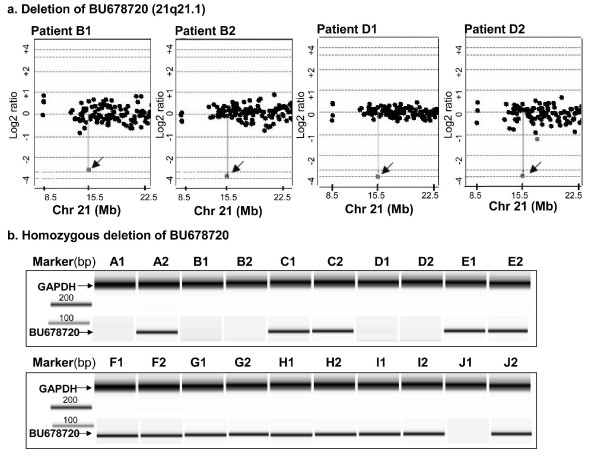
Concordant loss of BU678720 in sib-pairs of schizophrenics. (a) Array CGH profiles are shown for patients B1, B2, D1 and D2. The X axis marks the chromosome coordinate in megabases. The Y axis marks the hybridization ratio plotted in log2 scale. In these four patients, there is strong indication of a loss of BU678720 (Arrows). Graphics are produced by using Agilent software CGH Analytics version 3.4. (b) LOH analysis of BU678720. Gel view of the PCR products of BU678720 and GAPDH were shown for all affected sib-pairs. The specific amplified fragments of BU678720 and GAPDH were indicated. Graphics are generated by Agilent Bioanalyzer.